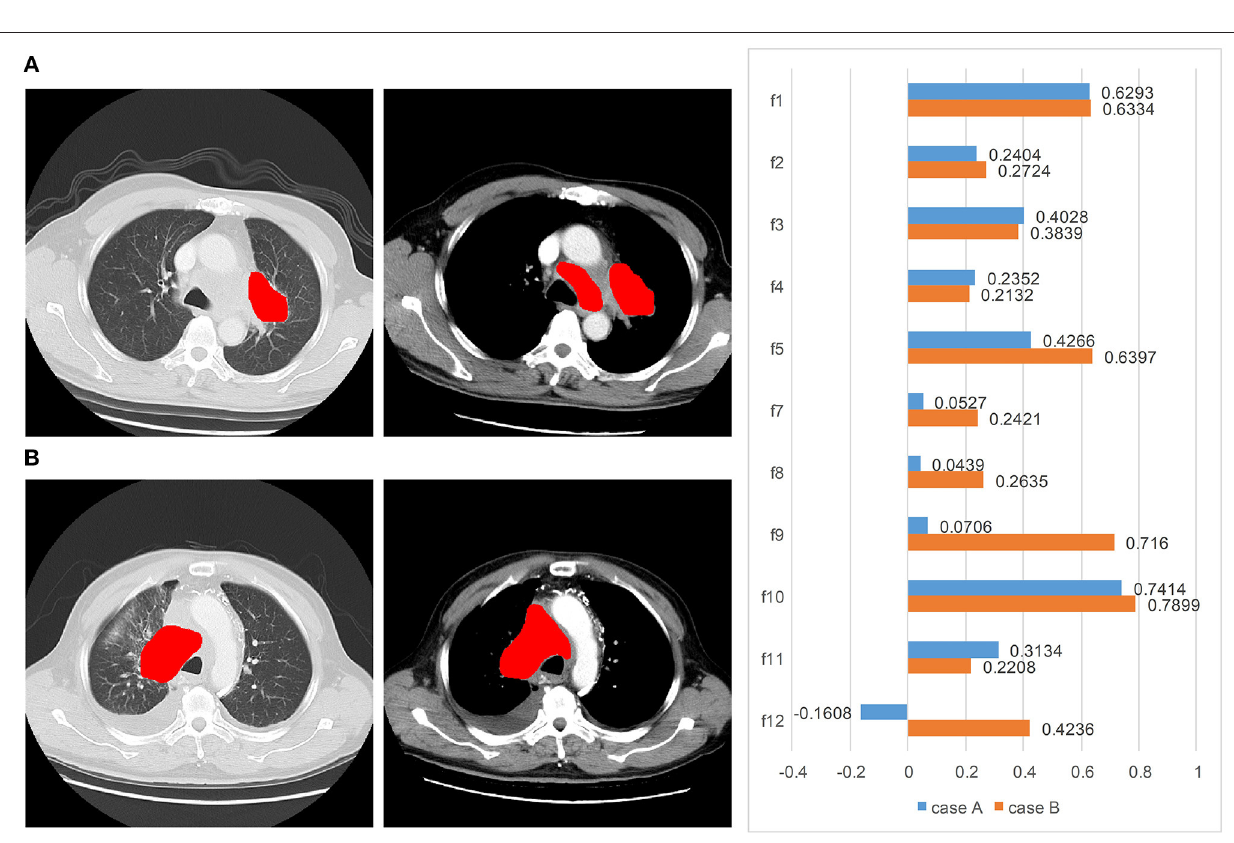
FIGURE 6 | Two typical cases from the visual analysis and our method: (A) a patient (male, age = 62 years, limited stage) with PFS of 90 days. Our model correctly predicted it with a high risk of 157.0, but the visual and clinical prognosis was good. (B) A patient (male, age = 67 years, extensive stage) with PFS of 431 days. Our model correctly predicted it with a low risk of 55.0, but the visual and clinical prognosis was poor. From left to right are the lung window CT, enhanced mediastinal window CT, and the feature weights,